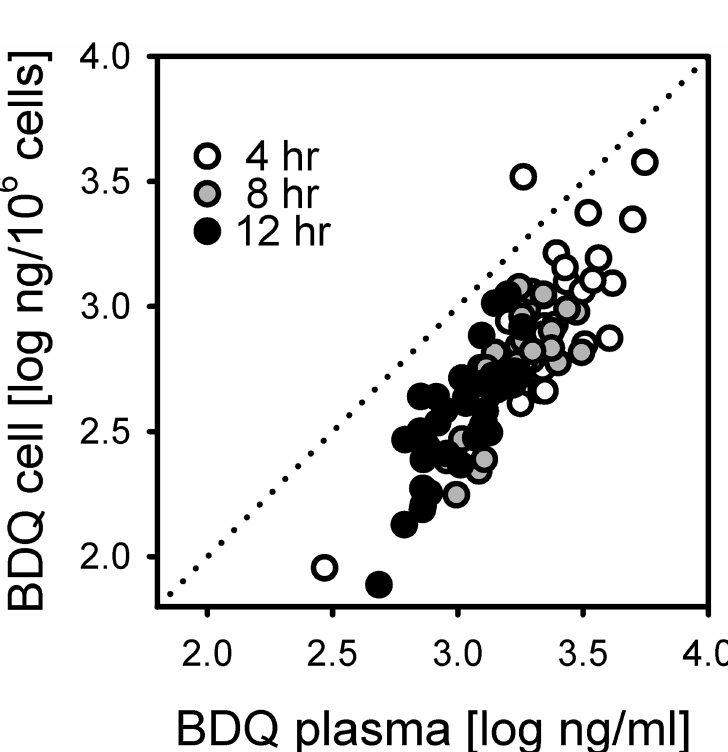
Fig 5. Relationship between measured bedaquiline concentrations in plasma and in blood mononuclear cells.